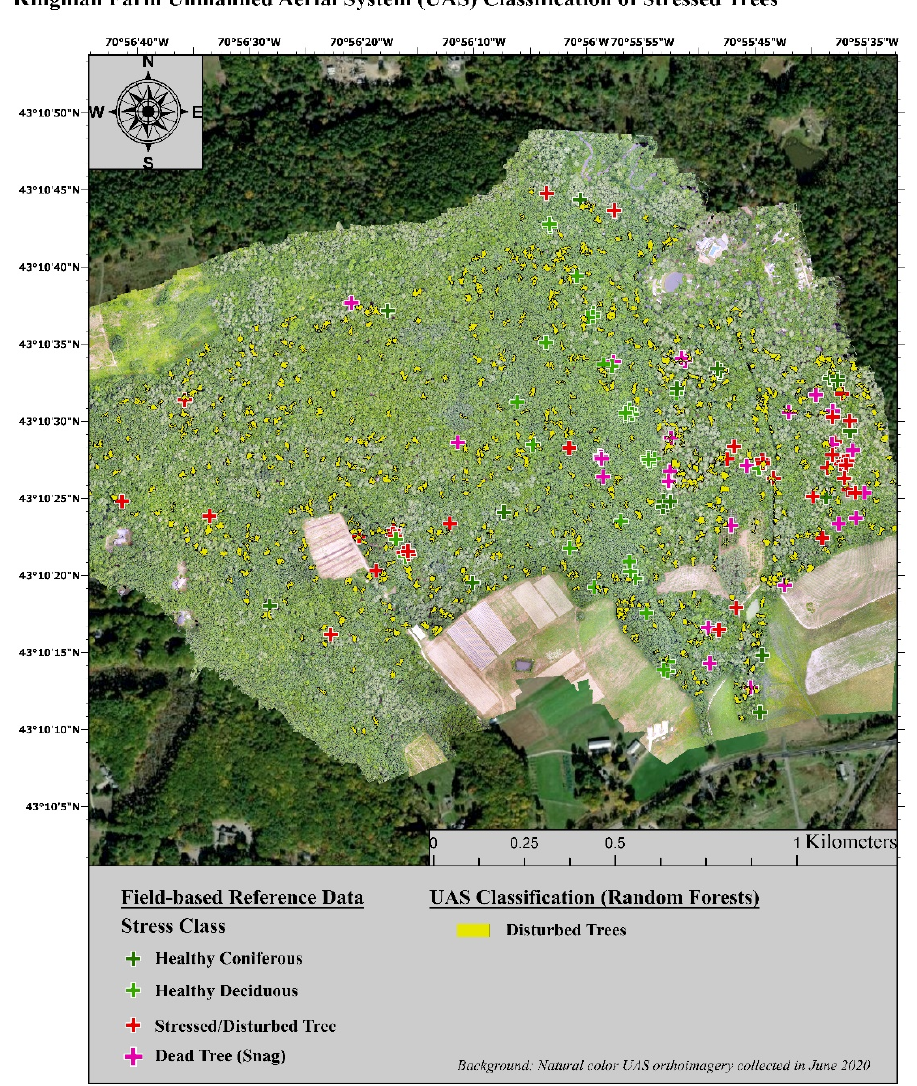
Figure 4. Example map of stressed trees classified using UAS multispectral